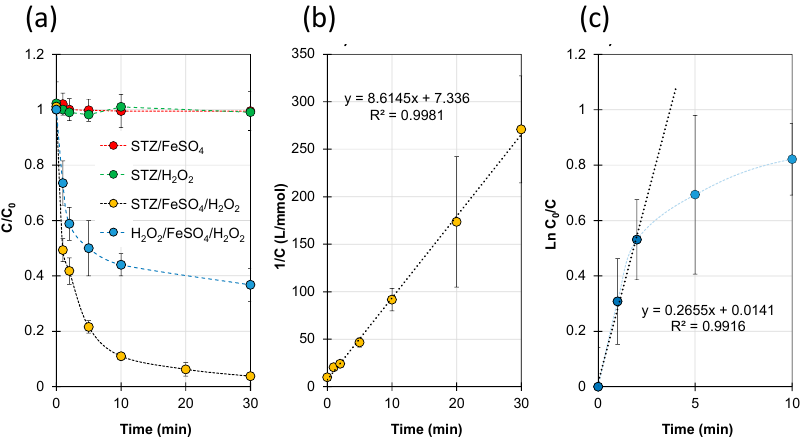
Figure 1. Dynamics of STZ and H 2 O 2 degradation in the presence of FeSO 4 and/or H 2 O 2 ; ( a ) changes in STZ and H 2 O 2 concentration during the reaction; ( b ) plot of the function 1/C = f(t) for change in STZ concentration; ( c ) plot of the function Ln( C 0 / C ) = f ( t ) for change in H 2 O 2 concentration. [FeSO 4 ] 0 = 0.15 mmol/L, [H 2 O 2 ] 0 = 2.0 mmol/L, pH = 3.35–3.45.